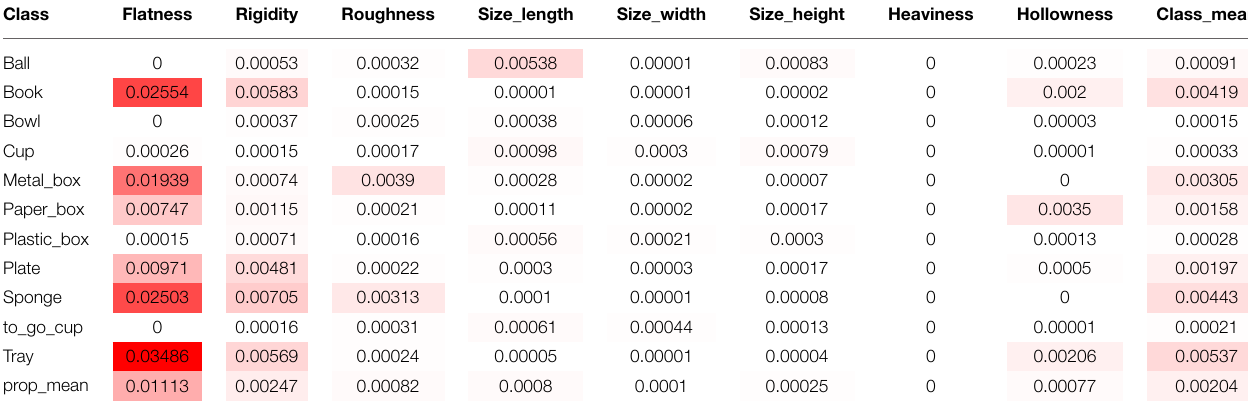
TABLE 2 | Mean variance for each physical property.